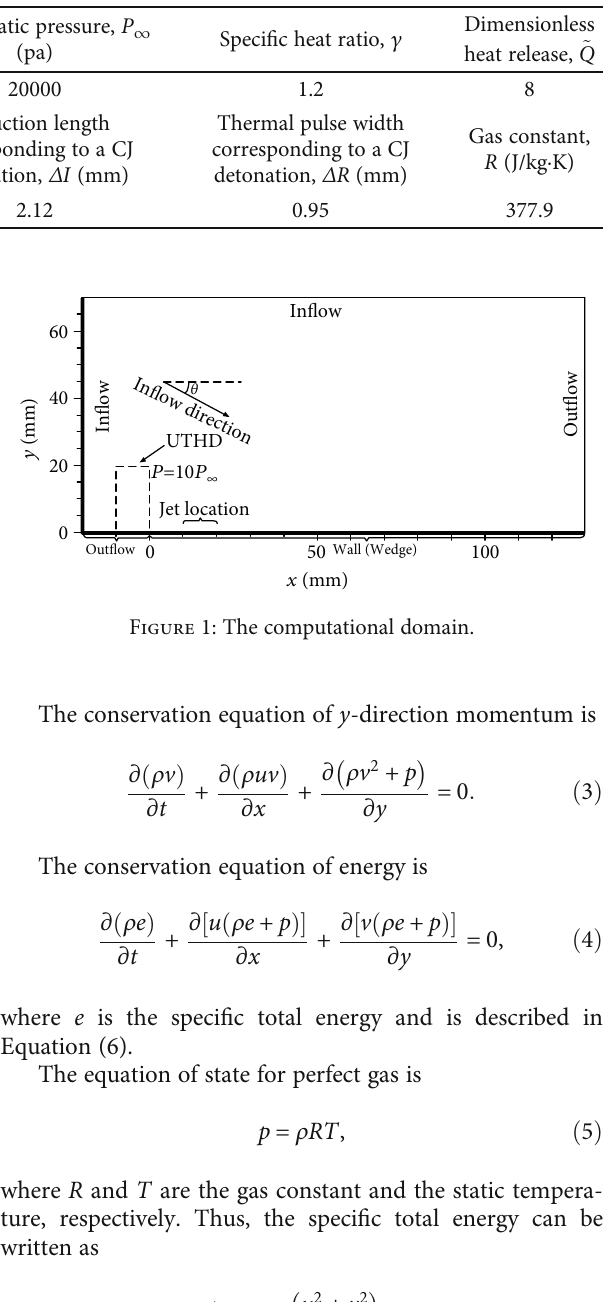
Table 1: Numerical parameter setup.